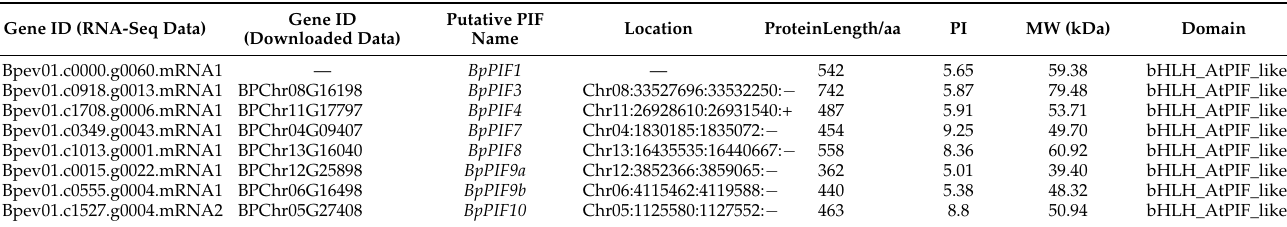
Table 1. Putative members of the BpPIF gene family of Betula platyphylla Suk . Gene ID (RNA-Seq